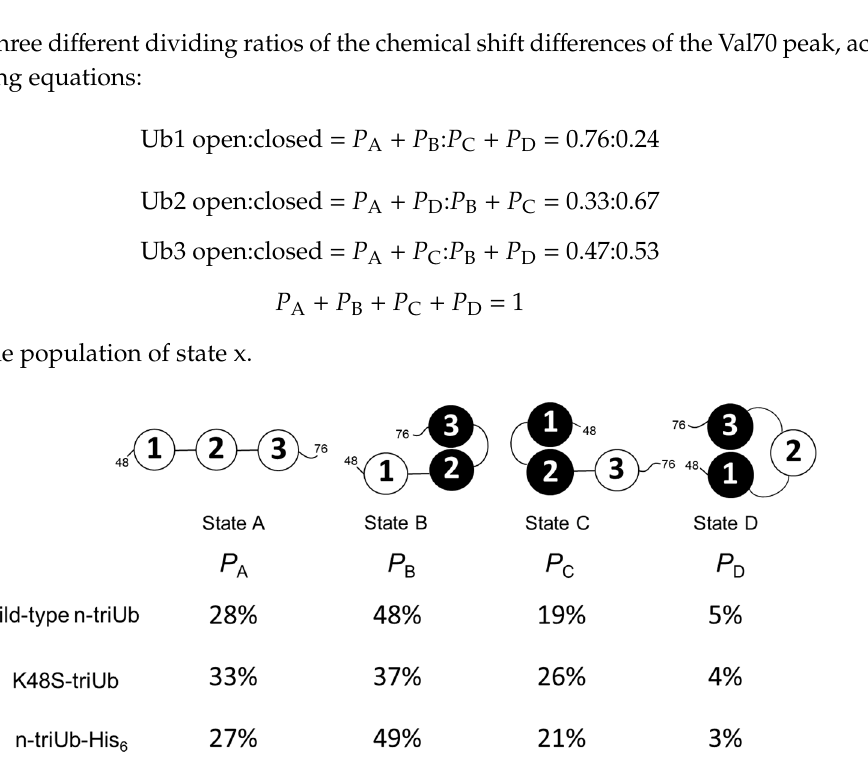
Figure 6. Cartoon model of the conformational equilibrium of n-triUb. The populations of states A, B, C, and D of n-triUb are denoted as P A , P B , P C , and P D , respectively. The calculated P A , P B , P C , and P D values of wild-type n-triUb, K48S-triUb, and n-triUb-His 6 are indicated.